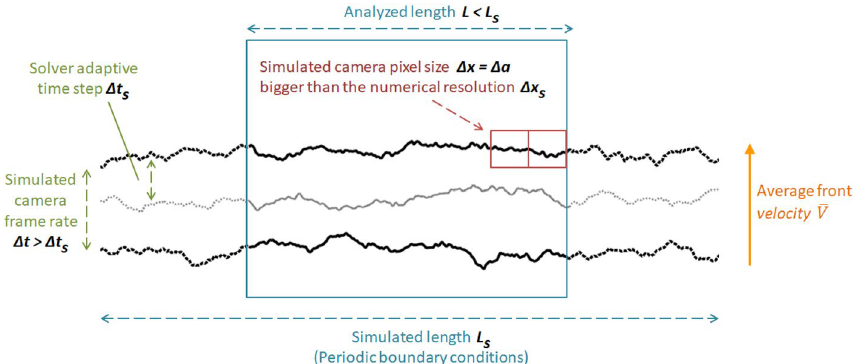
Figure 2. Illustration of the discretization principles and of the solver and observation grids. Three crack fronts at three successive times are shown, over which the parameters discussed in the “Discretization” section are